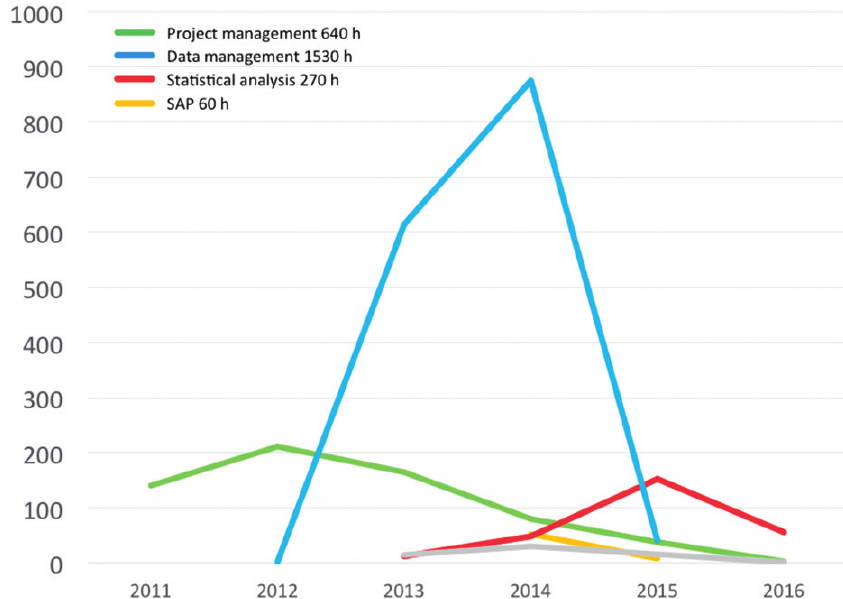
Figure 1. Time (h) spent on processes in the pilot study. SAP: statistical analysis plan.